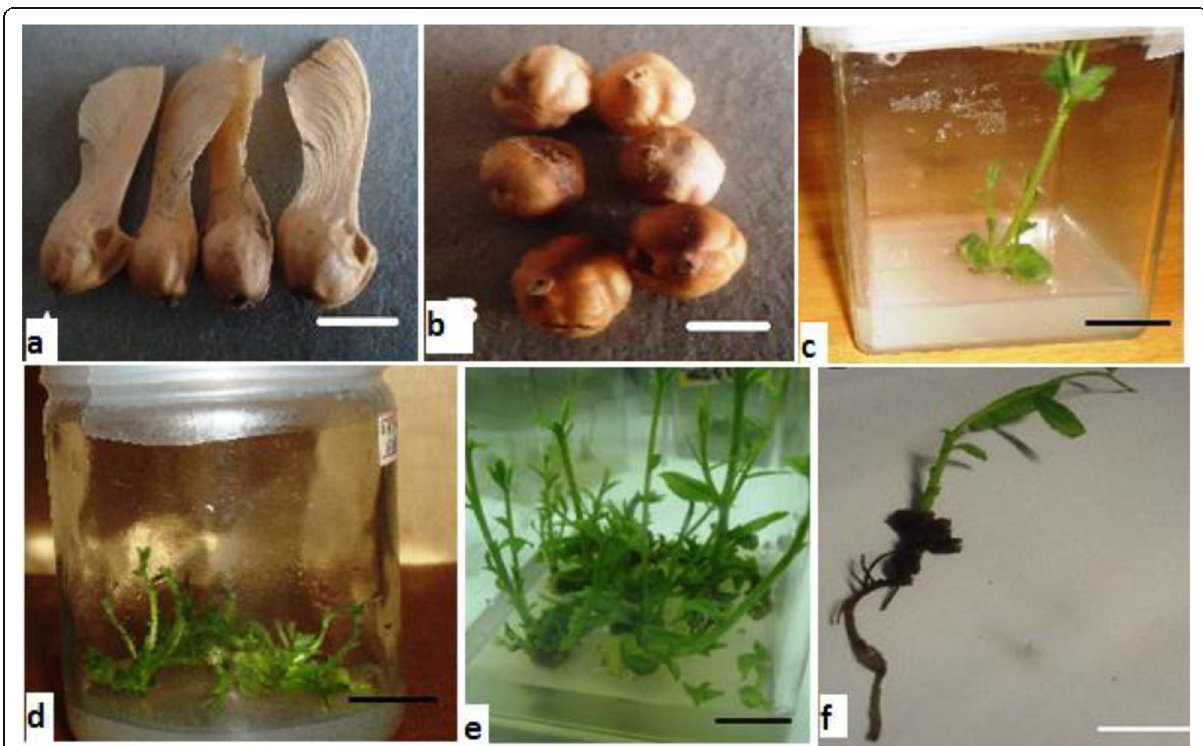
Fig. 1 In vitro propagation of S. longipedunculata. a Seeds with coat. b De-coated seeds. c Seedling on growth regulator-free medium. d Shoot initiation on MS medium containing 1.0 mg/l BAP. e Shoot multiplication on MS medium containing 1.5 mg/l BAP in combination with 0.1 IBA. f Rooted shoots on MS medium containing 2.0 mg/l IAA. Bars represent 2